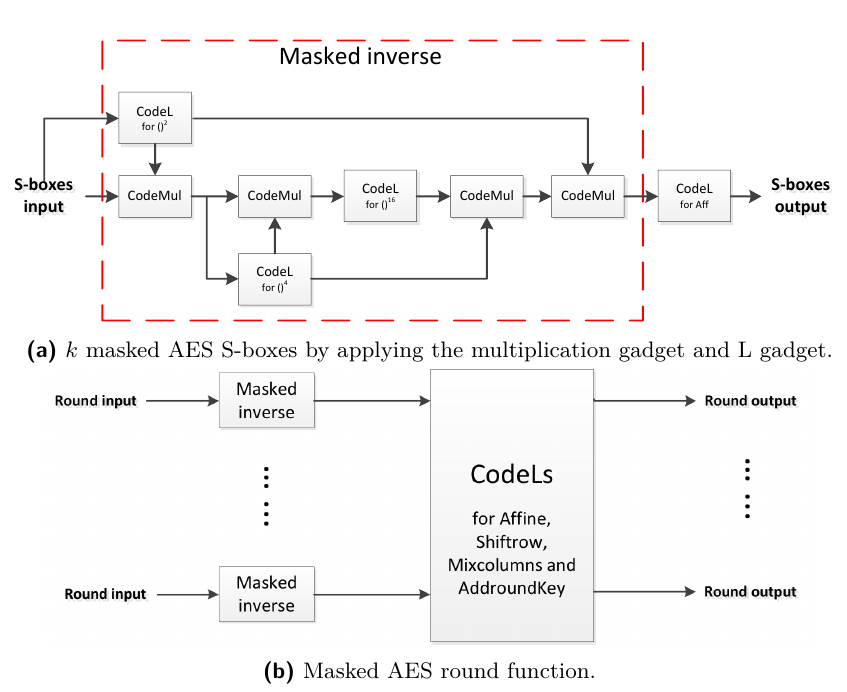
Figure 5: Masked AES S-boxes and round function by applying our masking